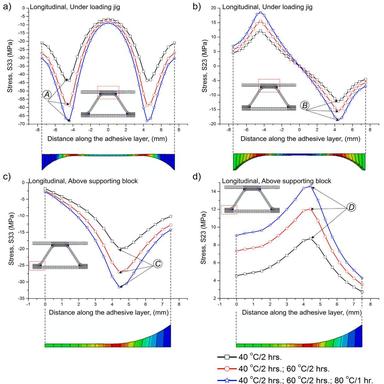
Stress distribution in the adhesive overlap and fillets of the ABCSS under longitudinal loading: a) normal and b) shear stresses under loading jig; a) normal and b) shear stresses above supporting block, with marks A, B, C, D indicating the corresponding peak stress locations.